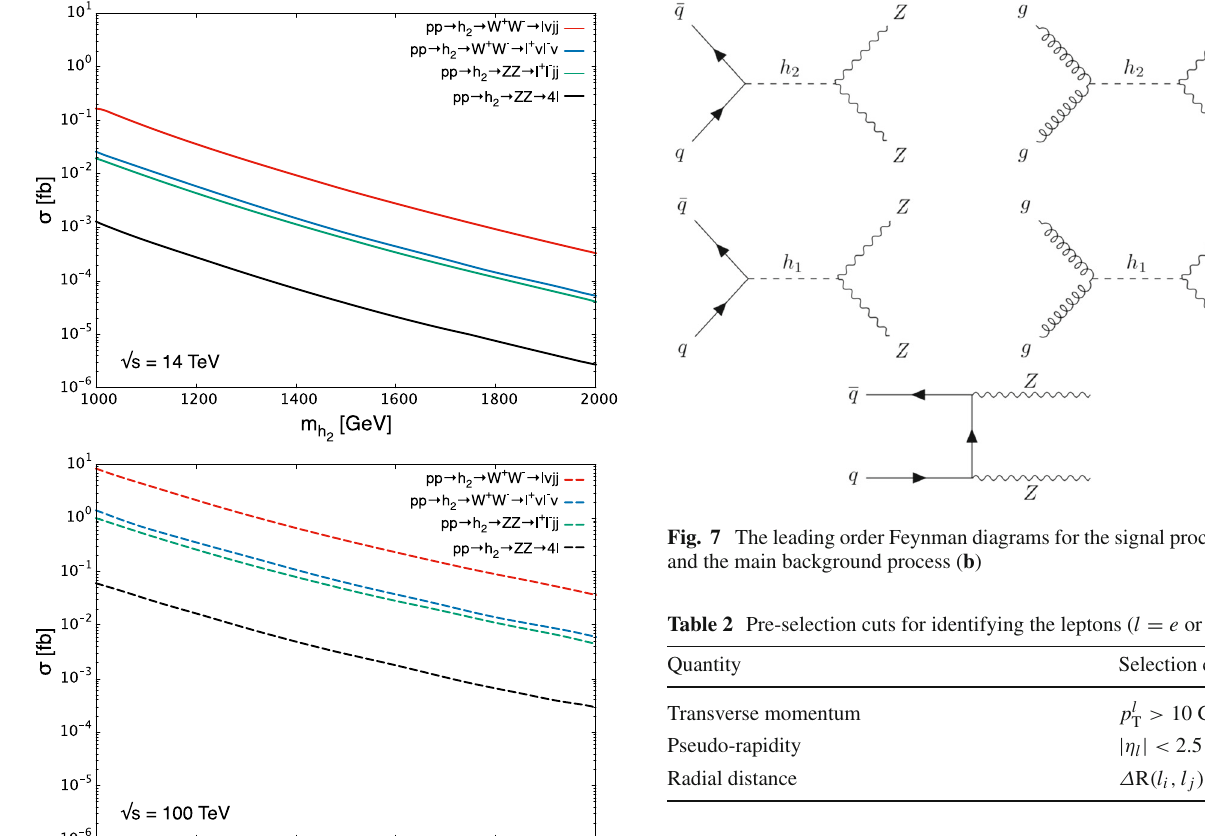
for 2 √ s = 14 TeV (up)